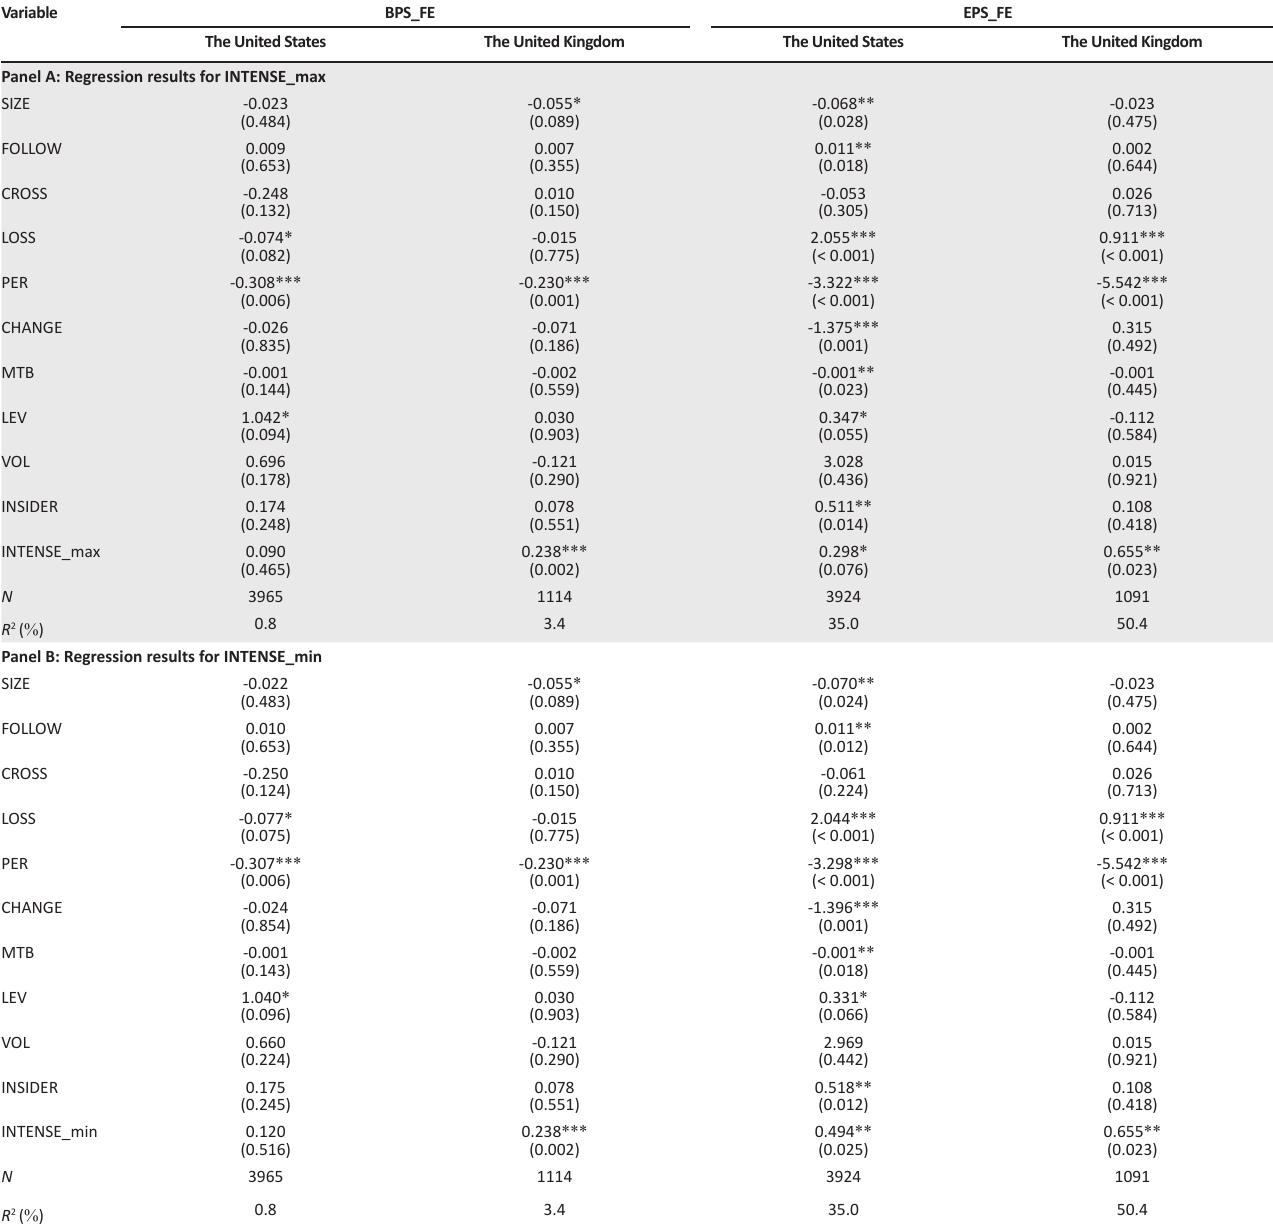
TABLE 4: Regression results with definite fair value accounting. Variable BPS_FE